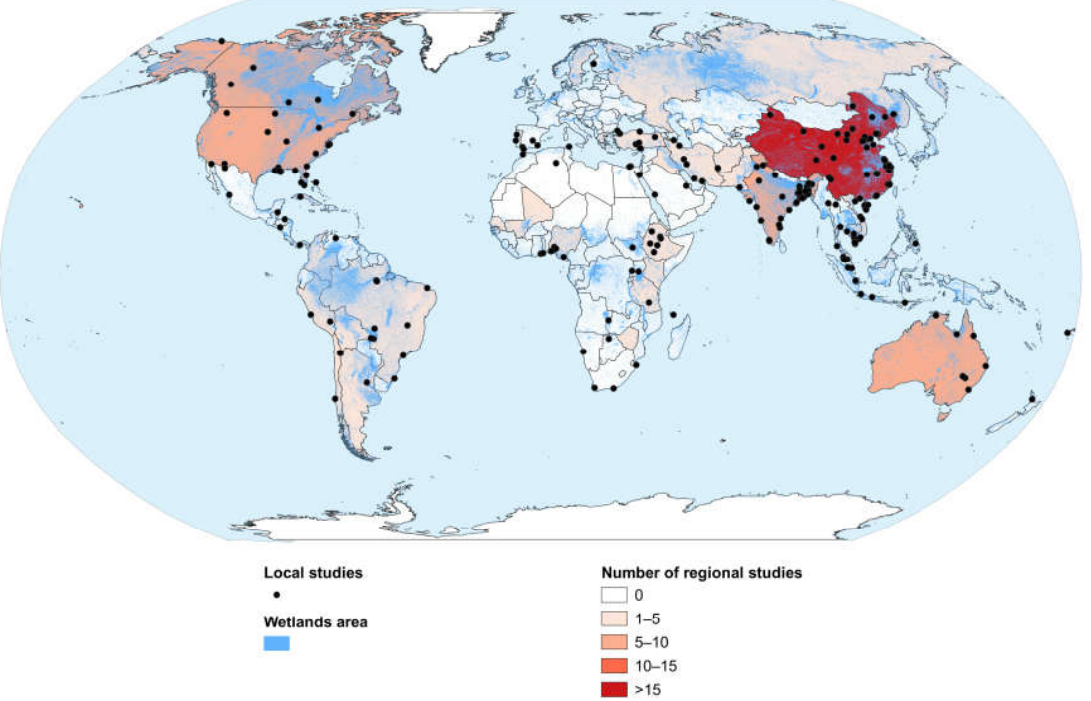
Figure 2. Spatial distribution of the reviewed studies. Source of the global wetland map: [29].